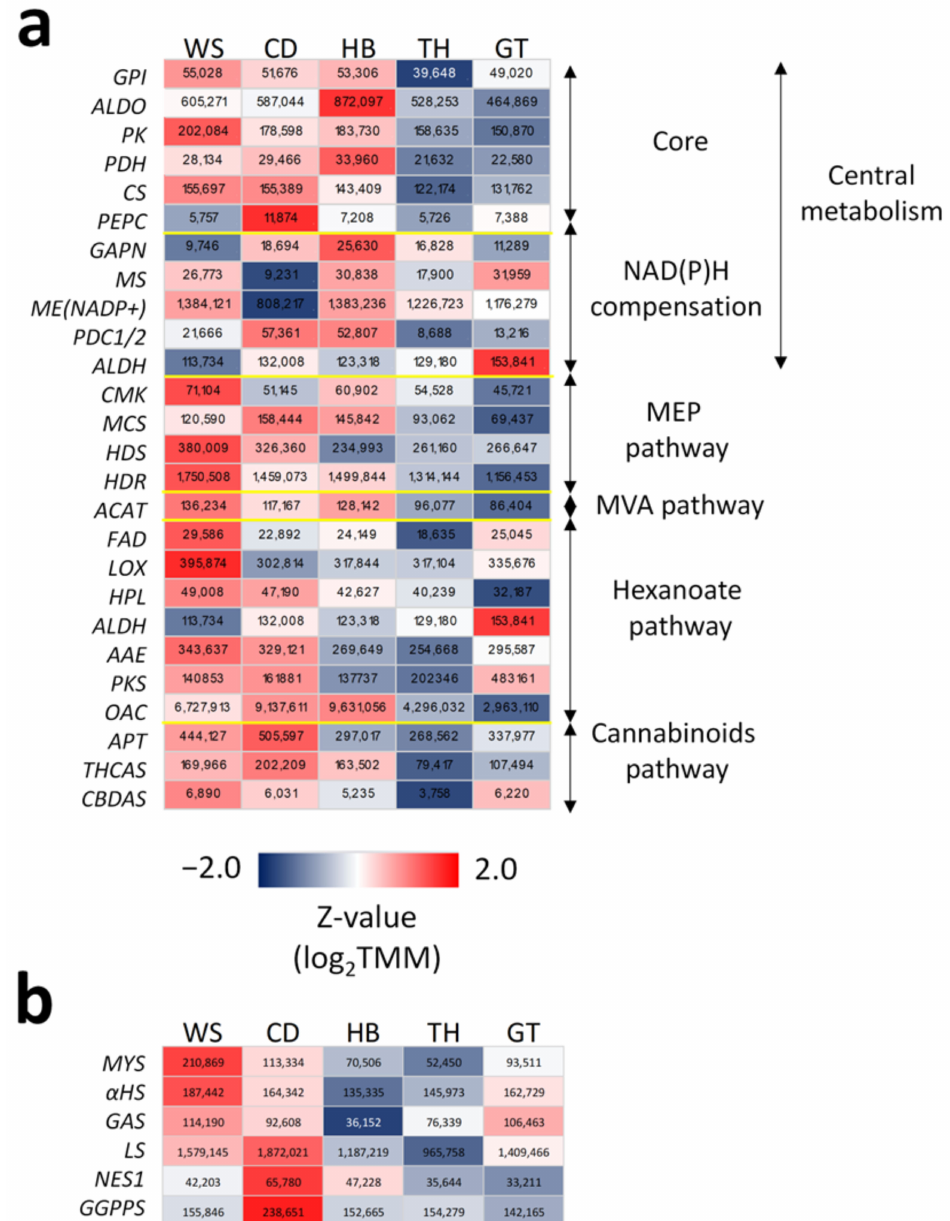
Figure 4. Biosynthetic profiles of Cannabis cultivars. ( a ) Cultivar-normalized expression heatmap of significantly regulated genes encoding metabolic enzymes involved in cannabinoid and terpene biosynthesis. The heatmap is based on the total expression values of genes that encode enzymes with the same products. The total gene expression values (TMM as units) are also given in each cell. Note that ALDH is associated with both NAD(P)H compensation and the hexanoate pathway. ( b )